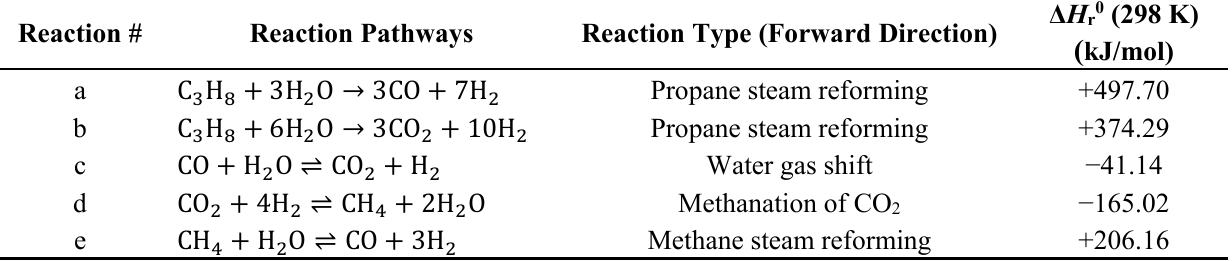
Table 1. Main reaction pathways during catalytic conversions of simulated exhaust feed at fuel rich